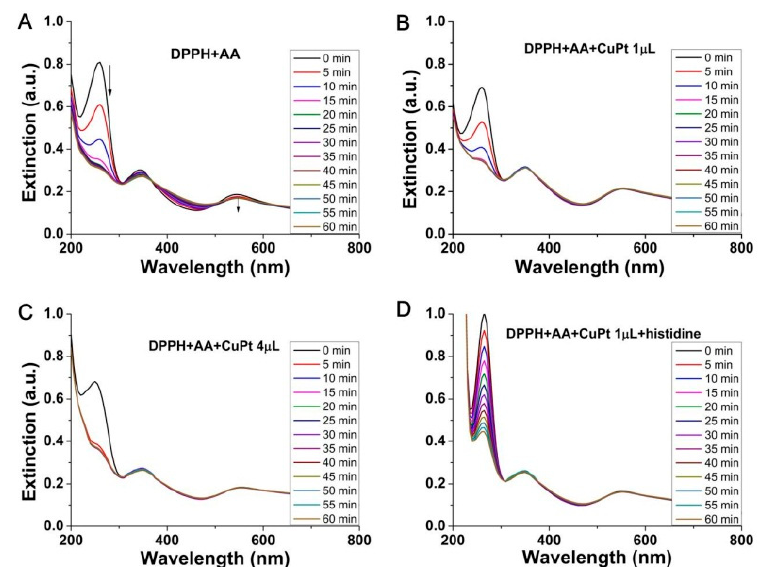
Figure 5. Antioxidant capacity of AA measured by α , α -diphenyl- β -picrylhydrazyl (DPPH) assay. The concentration-dependent acceleration of CuPt reacted with the mixture containing DPPH and AA measured by every 5 min. The concentrations are [DPPH] = 25 µ M, [AA] = 57 µ M, CuPt anocomposite were 0 µ L for ( A ), 1 µ L for ( B ) and ( D ), 4 µ L for ( C ), [histidine] = 6.40 mM for ( D ).